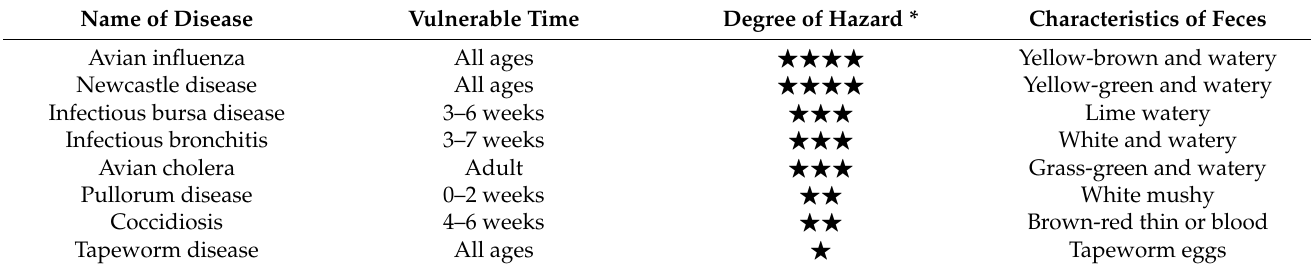
Table 1. Common diseases causing diarrhea in chickens and corresponding fecal